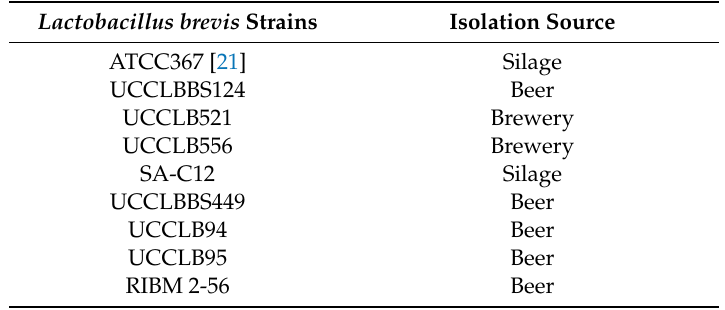
Table 1. Lactobacillus brevis strains used for phage isolation and